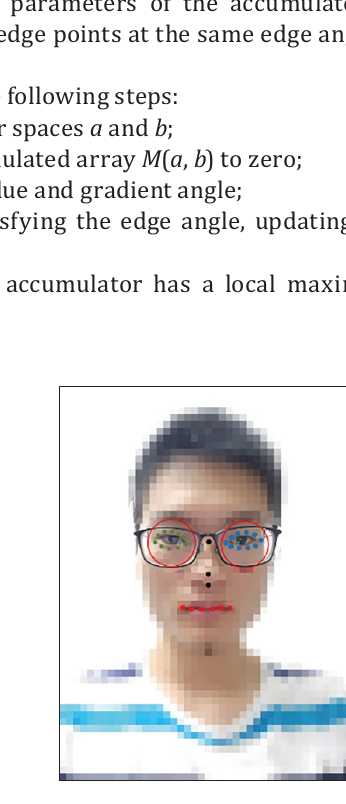
Figure 5. Image rendering results Figure 6. Result of recognition of eye and mouth contour feature